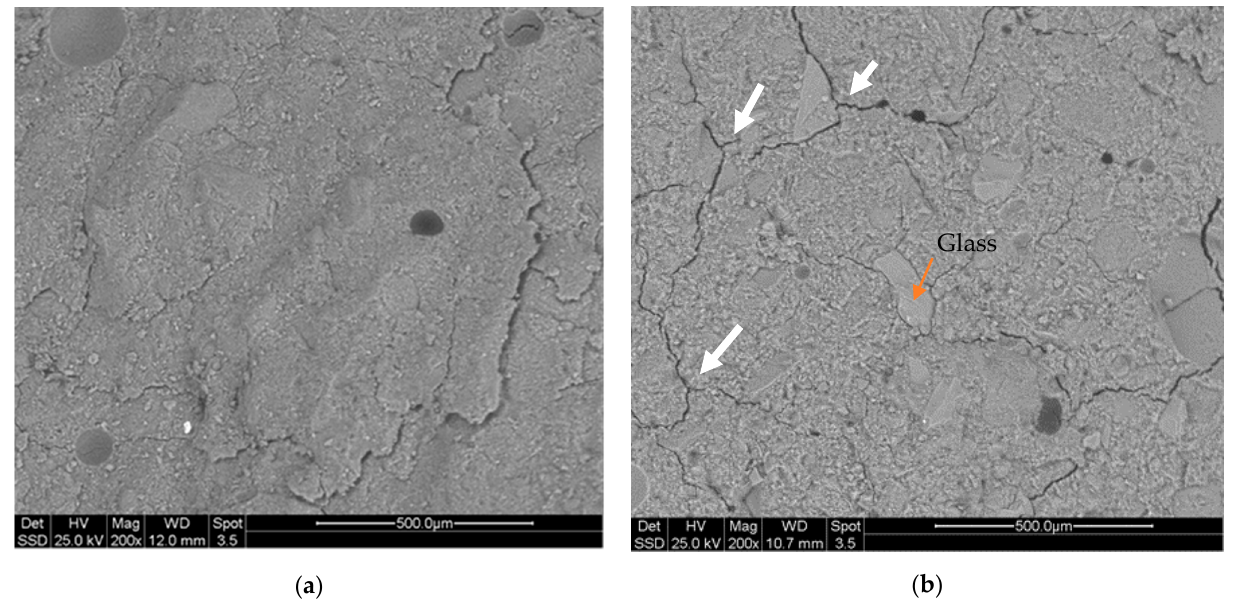
Figure 7. SEM micrograph of ( a ) KC_NF composition and ( b ) KC_WG composition after 28 days of curing.